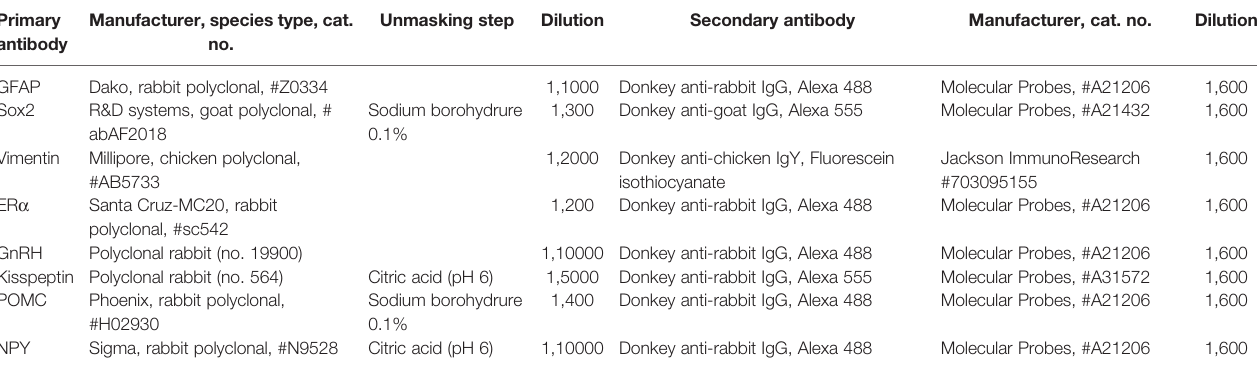
TABLE 1 | Primary and secondary antibodies used for